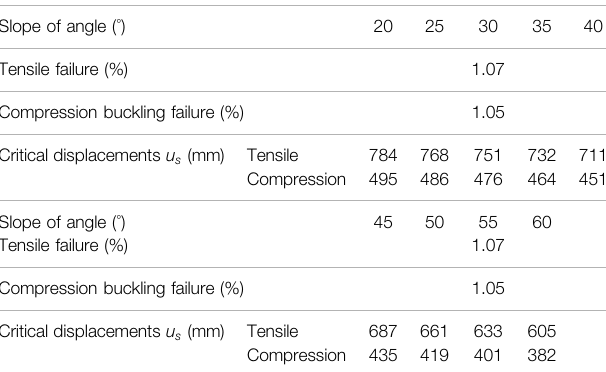
TABLE 4 | The results of critical displacements of thawing landslide of soil under ultimate